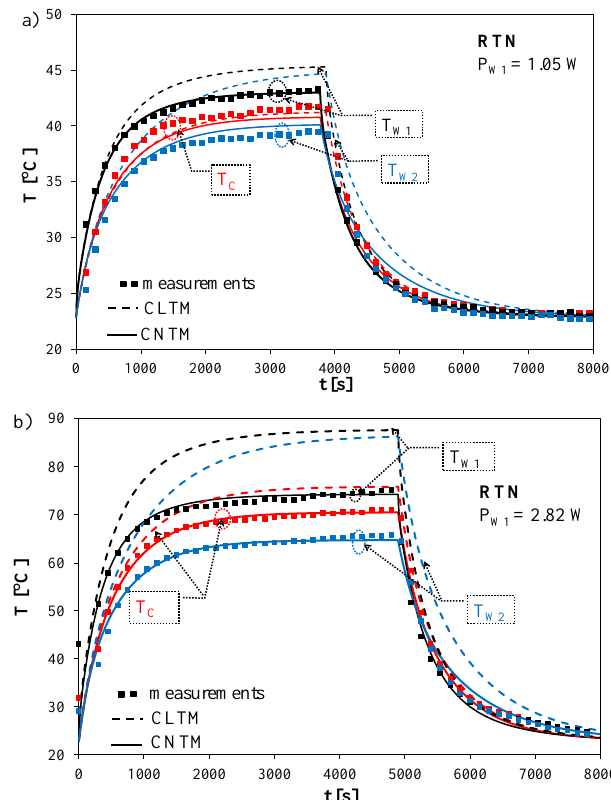
Figure 8. Measured and calculated temperature waveforms of the components of a transformer with a toroidal nanocrystalline core (RTN) at dissipated powers P W1 of 1.05 W ( a ) and 2.82 W ( b ) in the primary winding.